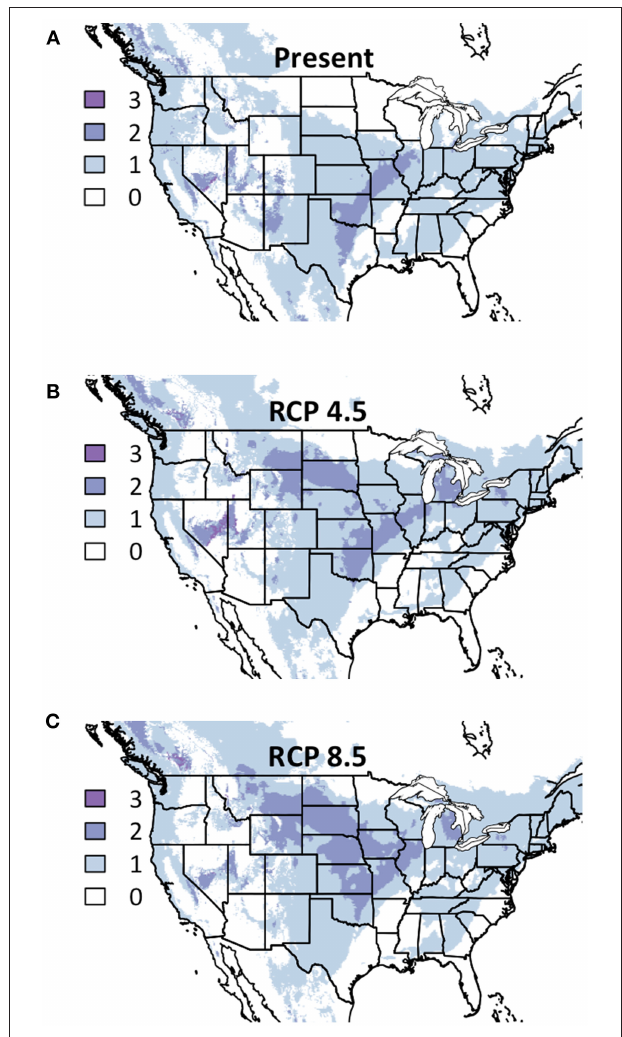
FIGURE 1 | Composite Map of Cool-Season Grass (A) Current Distribution and Response to (B) RCP 4.5 and (C) RCP 8.5. Colors indicate the number of species where suitability is predicted to ≥ 50%. Darker colors indicate areas where bioclimatic suitability is above the threshold for more species. Included species are Elymus virginicus , Koeleria macrantha , and Stipa spartea . Time period is identified in the top of each